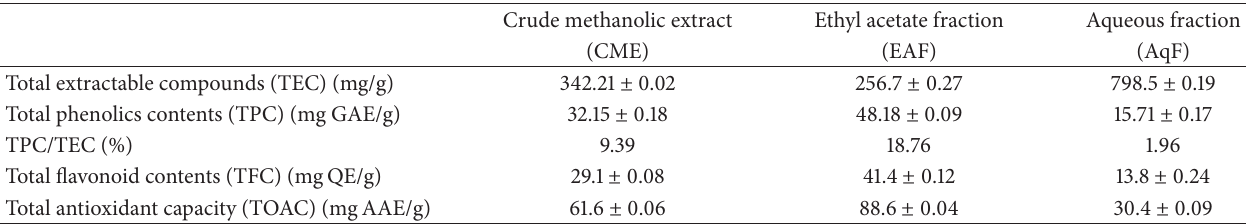
Table 2: Total extractable compounds (TEC), total phenolics contents (TPC), total flavonoid contents, and total antioxidant capacity (TOAC) of methanolic extract/fractions of L. coromandelica